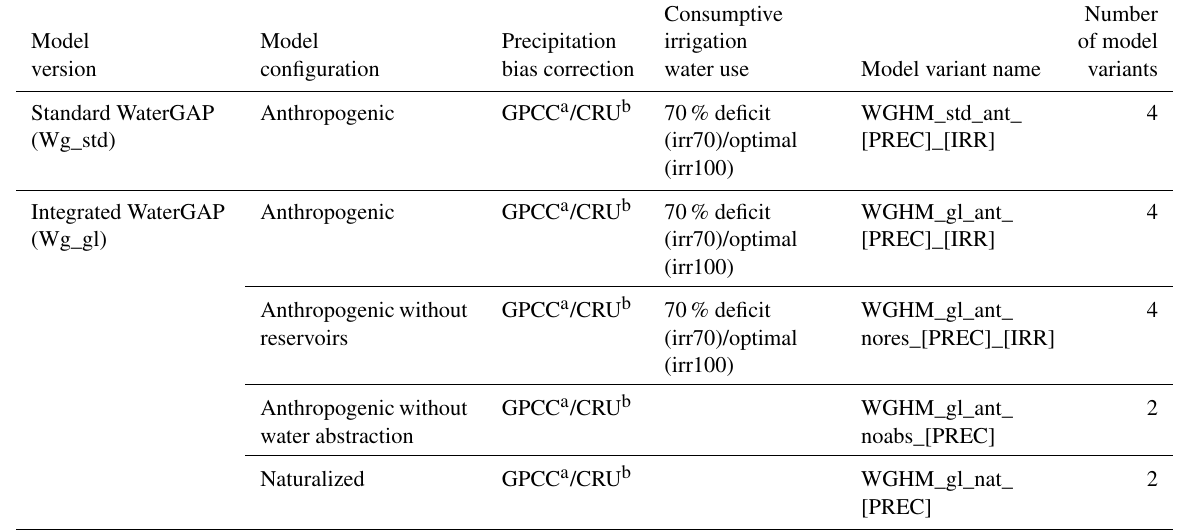
Table 1. Overview of model variants used in this study. The standard version of WaterGAP2.2d (Wg_std) and a non-standard version, which implicitly includes glaciers (Wg_gl), were run under four types of model configuration (namely anthropogenic, anthropogenic without reservoirs, anthropogenic without water abstraction and naturalized), two climate forcings differing in terms of precipitation bias correction (based on GPCC or CRU) and two assumptions related to consumptive irrigation water use (70% deficit and optimal).